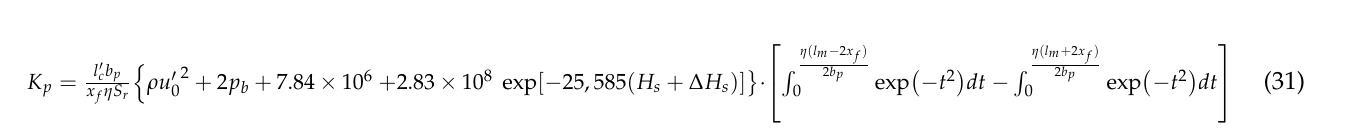
Figure 22. Installation error dependence of balance pressure.